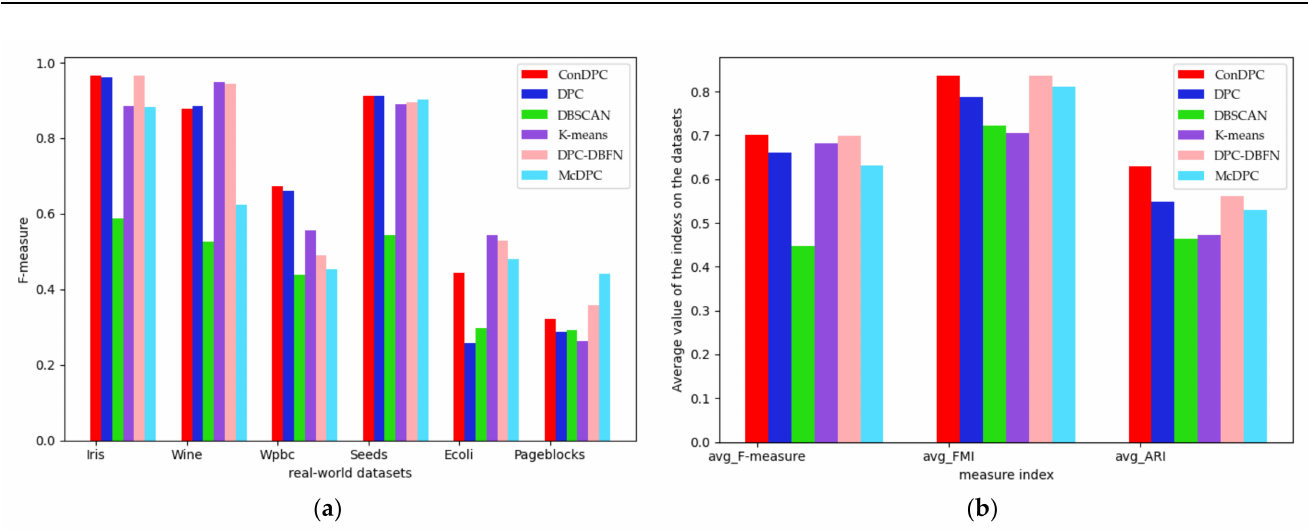
Figure 11. ( a ) F-measure of each algorithm on each dataset; ( b ) The average index values of each algorithm on the six